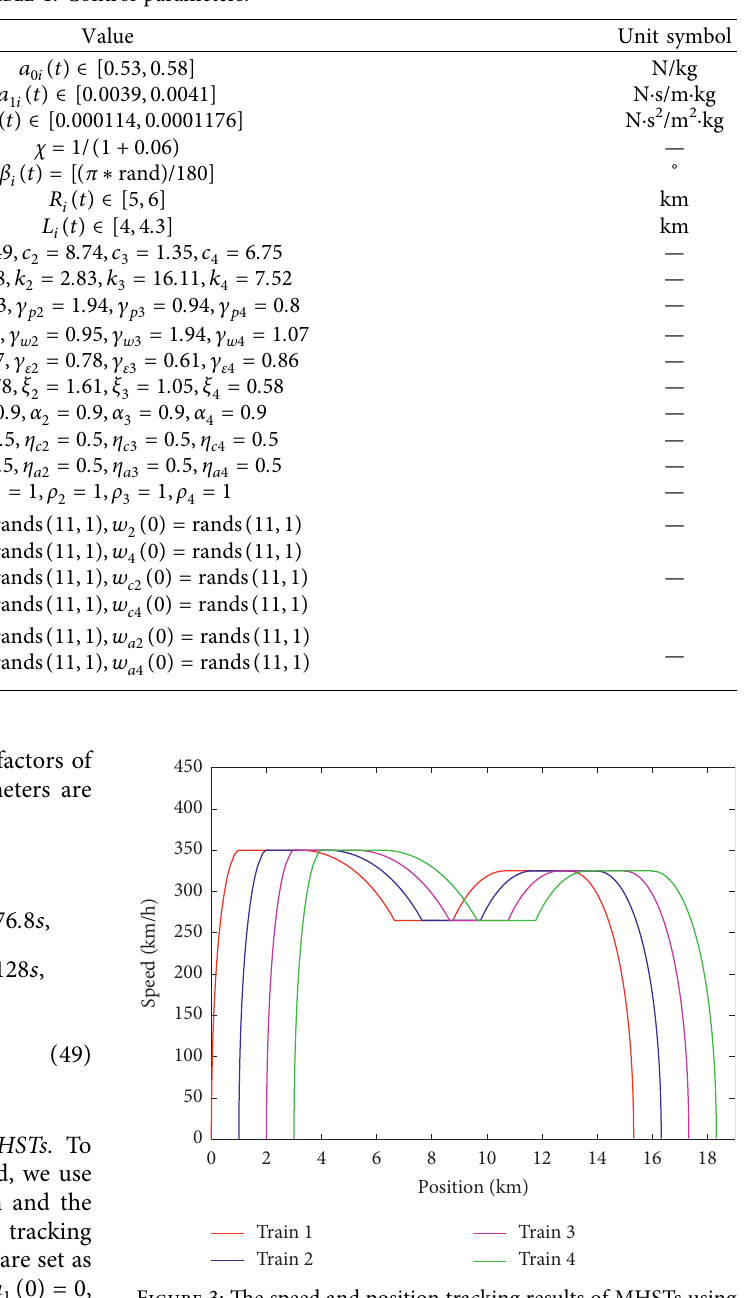
Table 1: Control parameters.